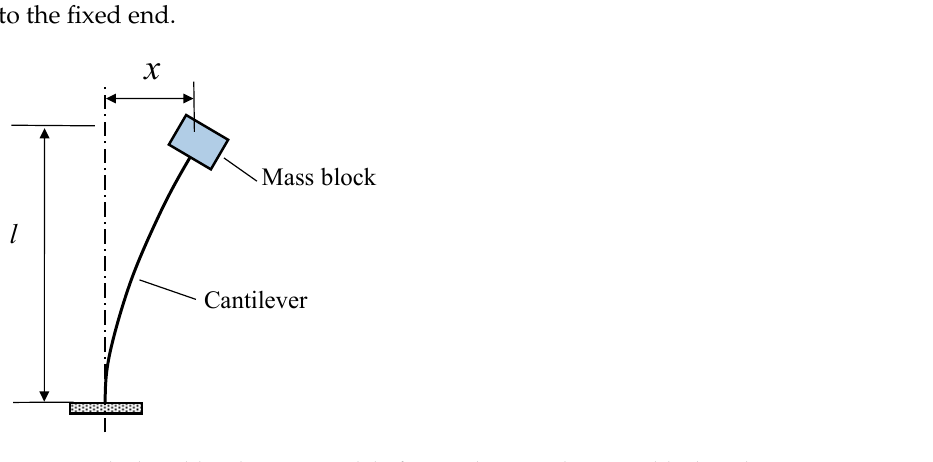
Figure 3. The bistable vibration model of a cantilever with a mass block at the tip.